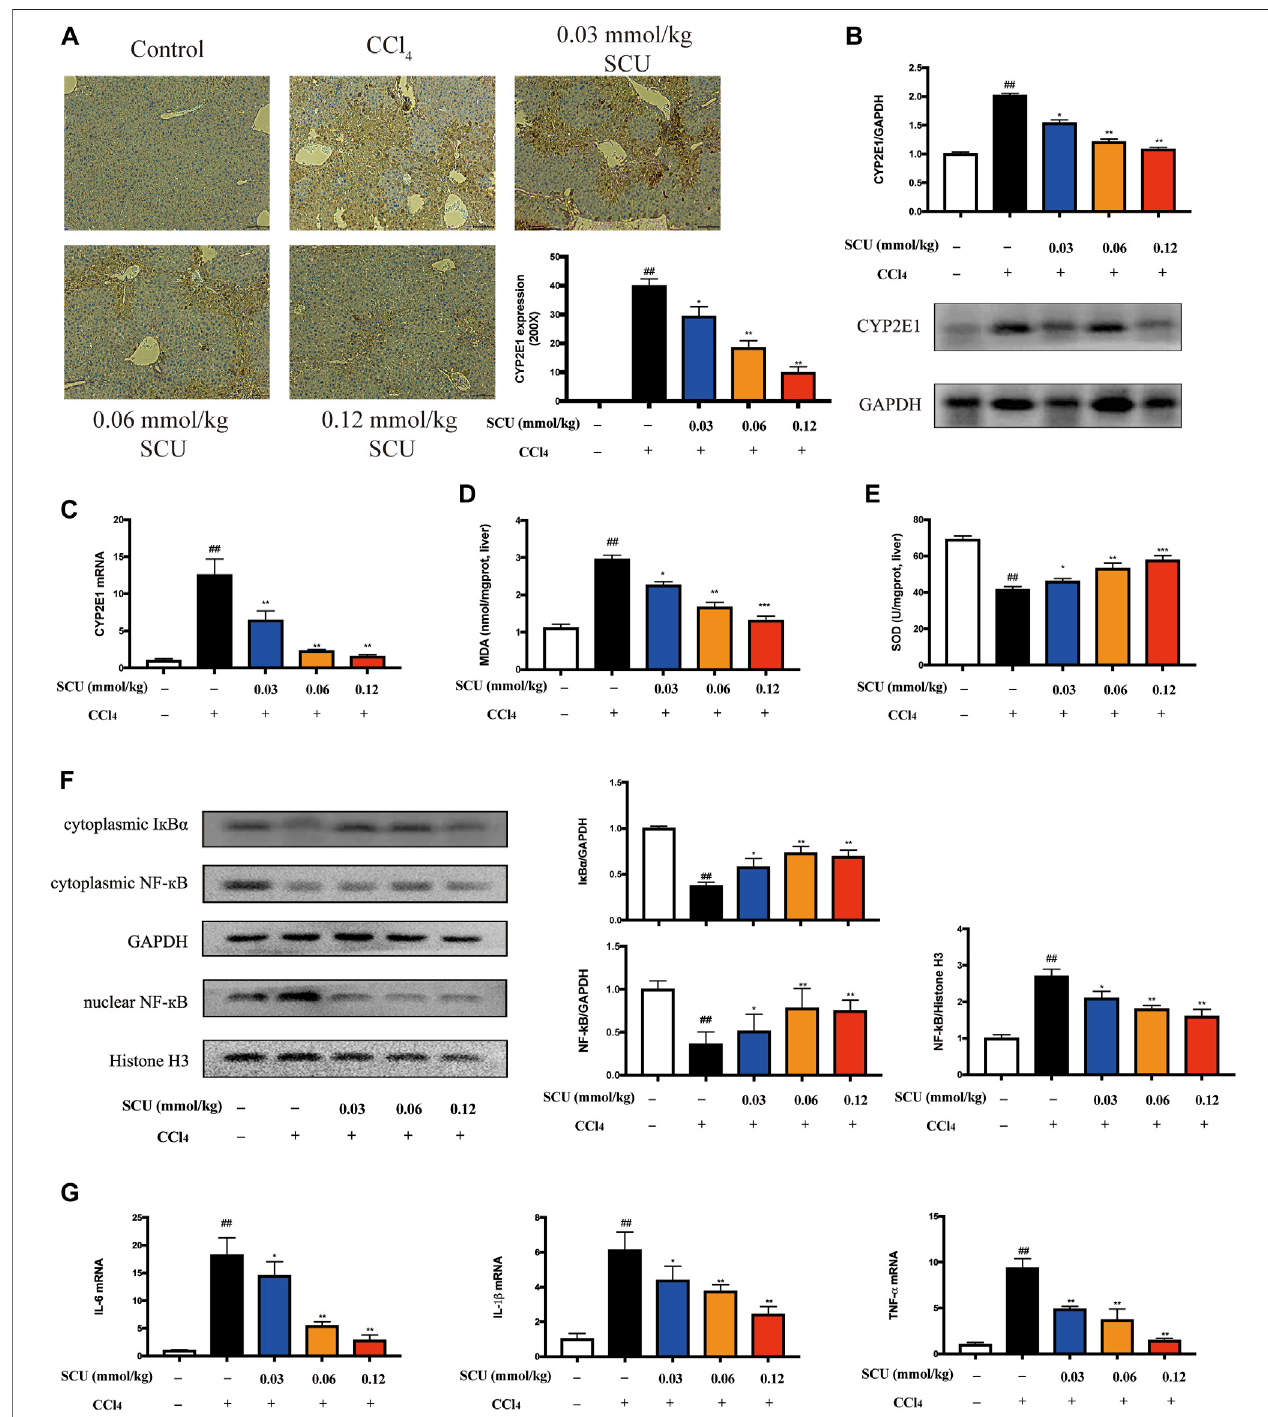
FIGURE3| SCU inhibited CYP2E1and NF- κ Binmice withCCl 4 hepatotoxicity. (A) Immunohistochemistry (yellow area,scale bar 50 μ m, magni fi cation 200 × ), (B) Western blot, and (C) RT-qPCR of CYP2E1. Hepatic content of (D) MDA and (E) SOD. (F) Western blot of I κ B α and NF- κ B. (G) Hepatic transcripts of IL-6, IL-1 β , and TNF- α ( n (cid:1) 5). ## p < 0.01 vs. control group; * p < 0.05, ** p < 0.01 vs. CCl 4 group.